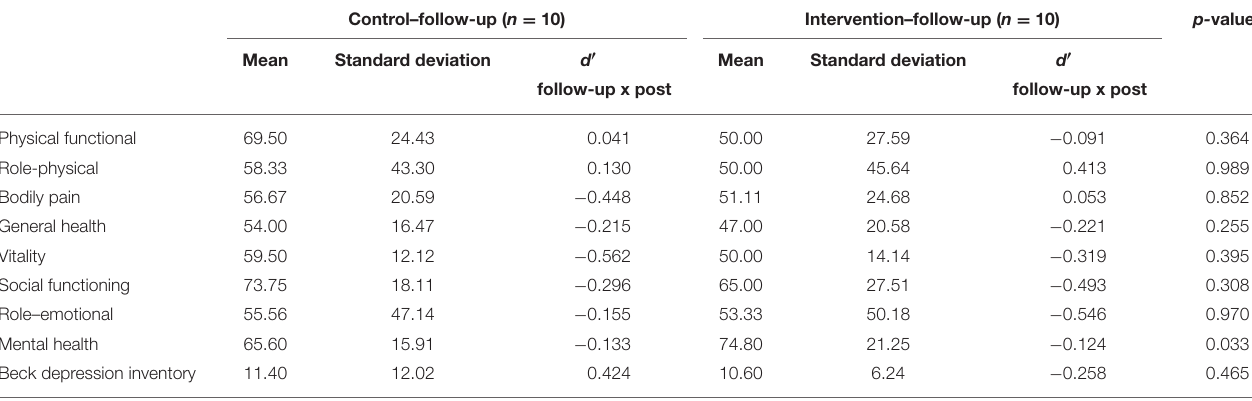
TABLE 4 | Comparisons of follow up between the control and intervention groups in relation to the quality of life questionnaire SF-36 and the Beck Depression Inventory ( n = 20). Control–follow-up ( n = 10)